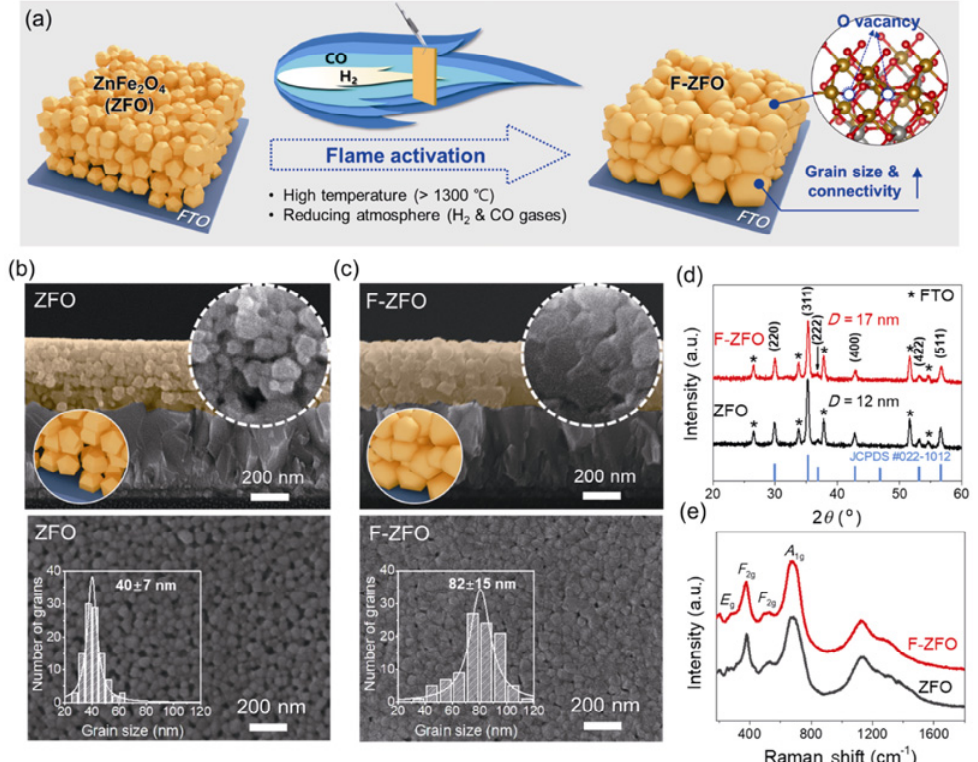
Fig. 1 Flame activation of the ZnFe 2 O 4 (ZFO) photoanode. (a) Flame activation and its impacts on grain size, connectivity, and oxygen vacancy formation of ZFO. The high temperature and reducing flame promote grain fusion/growth and generate oxygen vacancy. SEM images of (b) ZFO and (c) flame-activated ZFO (F-ZFO). (d) XRD pattern and (e) Raman spectra of ZFO and